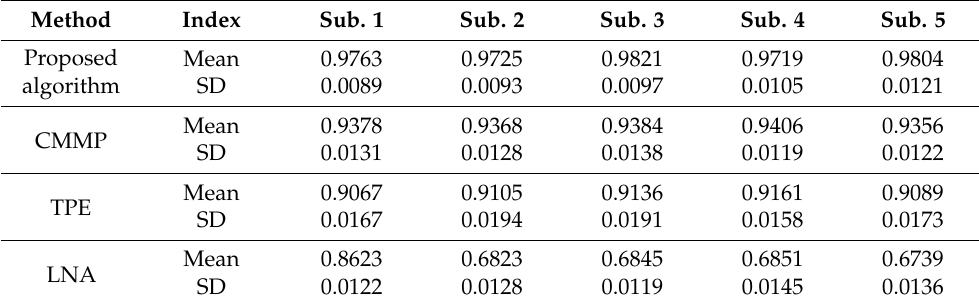
Figure 11. The similarity curves of different methods based on subject 2. Table 6. The similarity values of different